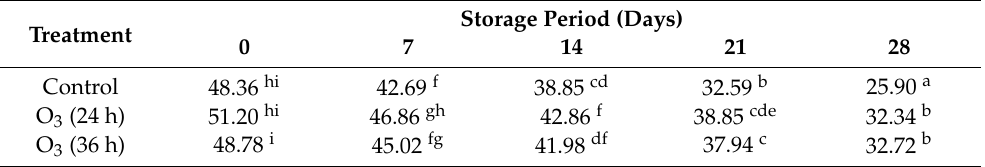
Table 1. Effect of gaseous ozone (0.25 mg/L) on the firmness of mango fruit inoculated with L. theobromae , stored at 10 °C for three weeks and ripened at ambient temperature for seven days. Storage Period (Days) Treatment